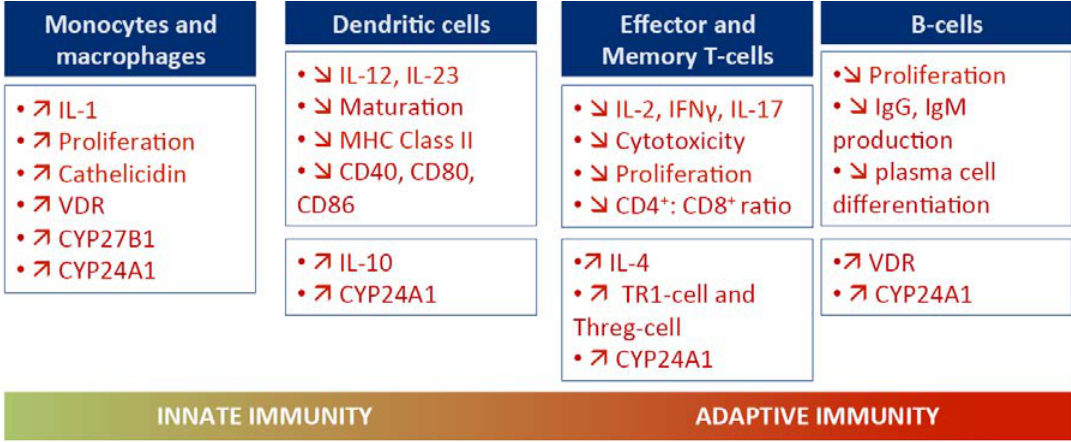
Figure 1. Mechanisms by which 25(OH)VitD and 1,25(OH) 2 VitD modulate innate and adaptive immune response (up) and overview of immunomodulatory actions on monocytes and macrophage; dendritic cells; and effector and memory T and B-cells (down). All these cells possess the enzyme (CYP27bB1) for hydroxylation steps to generate 1,25(OH) 2 VitD. Through endocrine, intracrine and paracrine mechanisms, the active form of VitD binds to the VitD receptor (VDR) to induce a wide range of immunological effects (adapted from Lang et al.